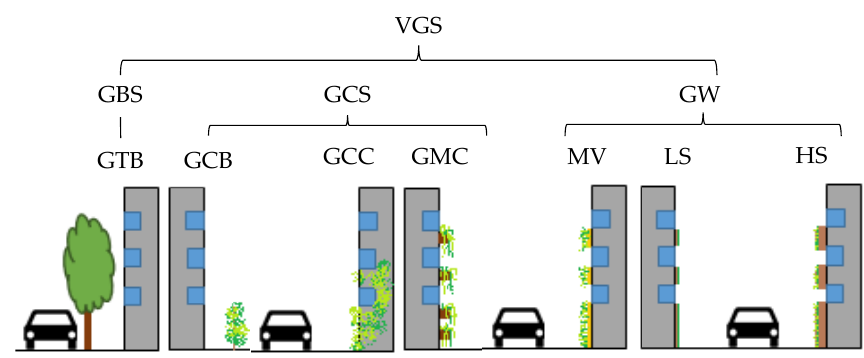
Figure 2. Vertical greenery system classification, based on [30].